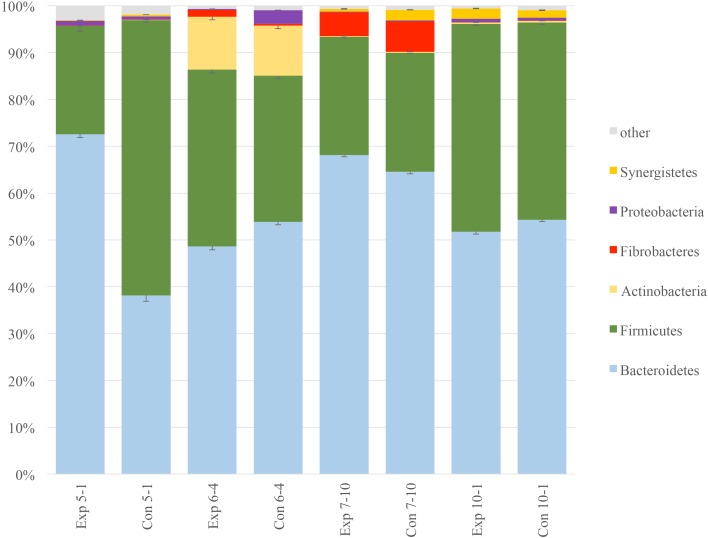
Effect of time and bacterial probiotic on the bacterial diversity at the phylum level of the lamb rumen over the first six months of life.X-axis labeled reflect treatment (Con = control, Exp = probiotic experimental), as well as sampling date. Error bars show standard error mean.